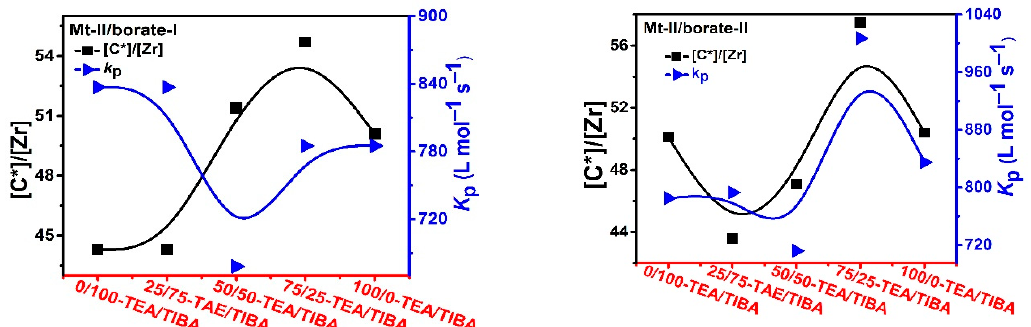
Figure 5. Active center ratio and k P of ethylene polymerization with Mt-II/borate/alkylaluminum.